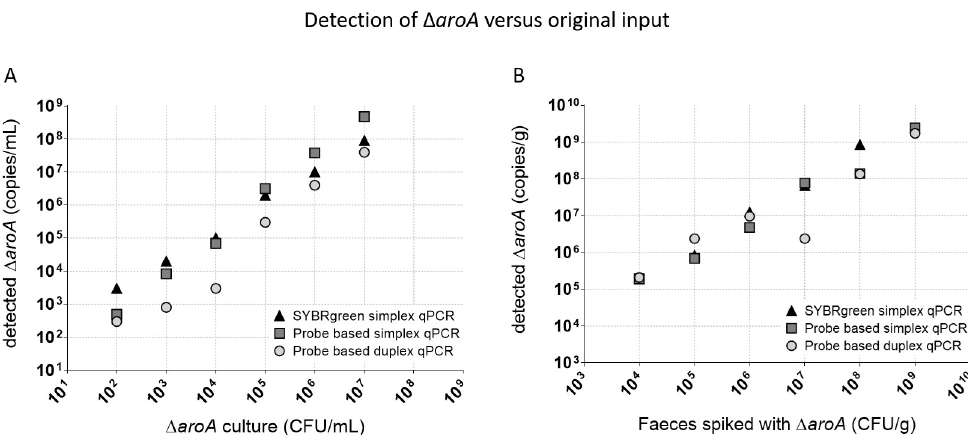
Fig 3. Amount of detected copies/ml Δ aroA vs original input. The amount of detected Δ aroA (copies/ml) for the three different qPCRs (the SYBRgreen simplex qPCR (black triangles), probe-based simplex qPCR (dark grey squares) and probe-based duplex qPCR (light grey circles) is depicted. (A) The input of the qPCR is genomic DNA originating from a 10-fold dilution series of an overnight culture from the Δ aroA strain. (B) The input for the qPCRs is DNA isolated from fresh chicken faeces spiked with a 10-fold dilution series of the Δ aroA